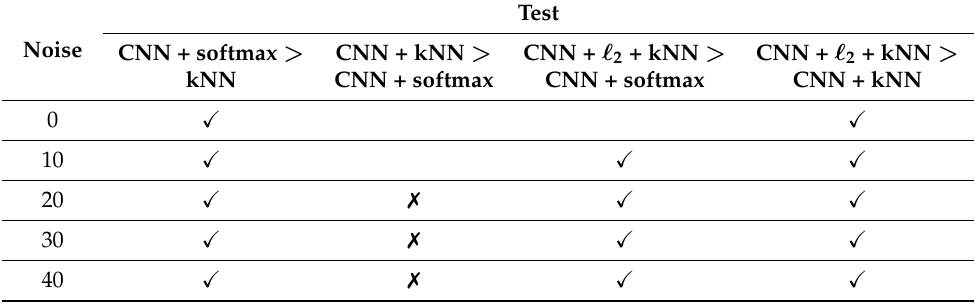
Table 4. Results obtained for the statistical significance tests with respect to the synthetic noise induced in the data. The symbol (cid:88) states the test is significantly accepted, whereas (cid:55) states that the test